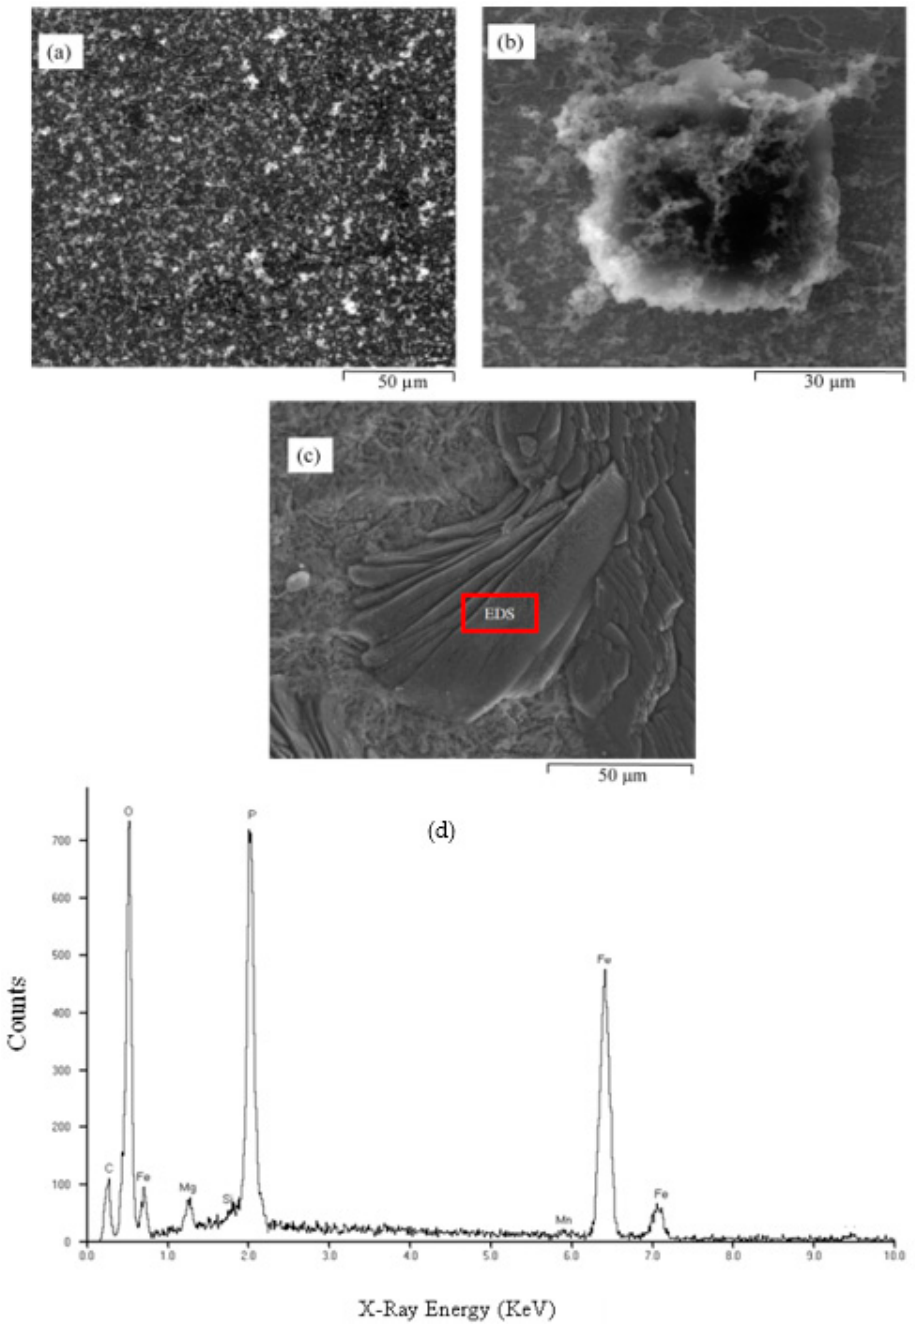
Figure 9. ESEM images of hydrated biofilm formed on carbon steel due to a pure IRB culture following 168 h exposure in the modified Postgate C medium: ( a ) overall covering (inorganic and organic components), ( b ) an iron oxyhydroxide shell covered in adhesive EPS material and ( c ) SEM image of precipitates of an iron phosphate species. ( d ) EDS analysis of the layered, plate-like deposit in Figure 9c.